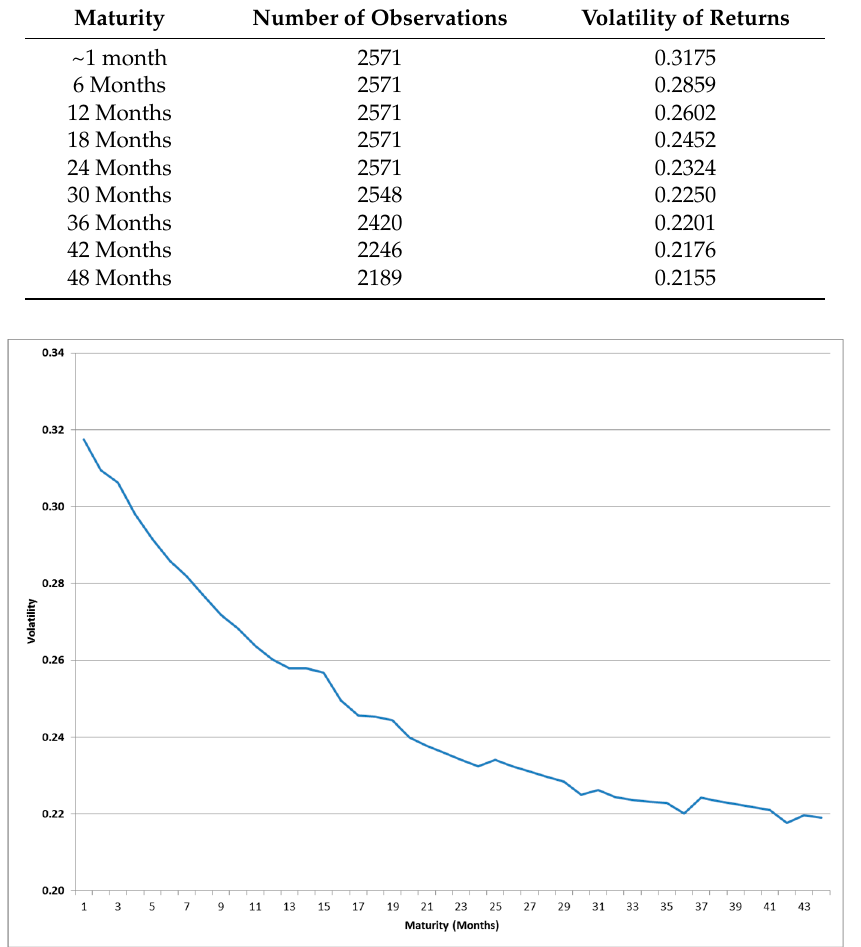
Table 2. Some Futures Contract volatility levels according to their maturity.